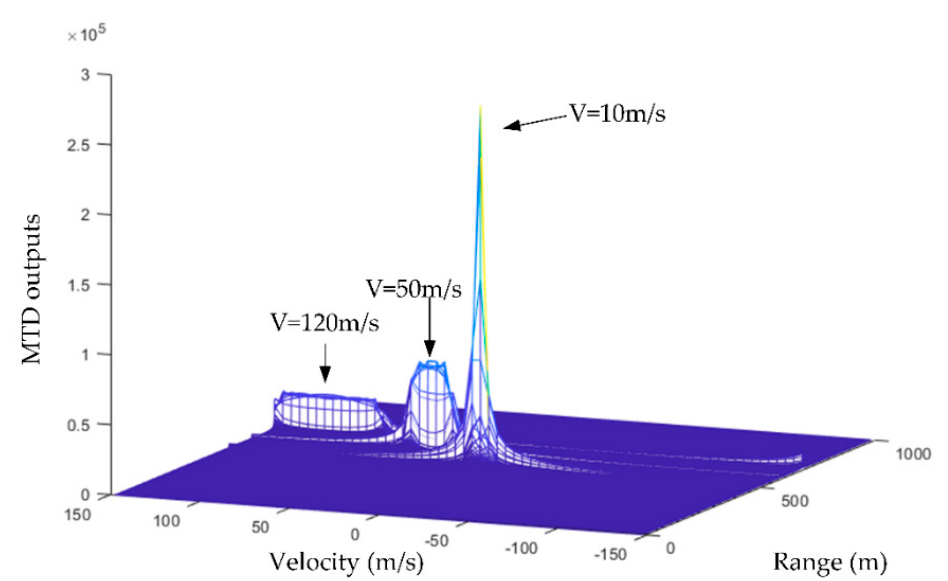
Figure 9. Comparison of MTD gains of scattering centers at different velocities.